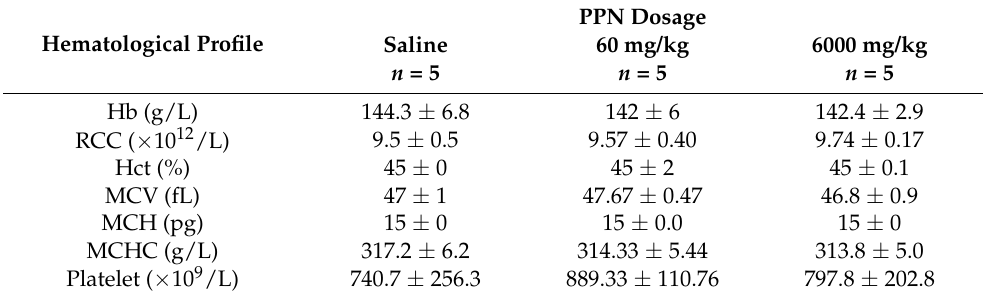
Table 2. Hematological parameters of BALB/c mice 14 days following a single IV administration of PPNs (acute-dose toxicity). The data are expressed as mean ± standard deviation ( n = 5).